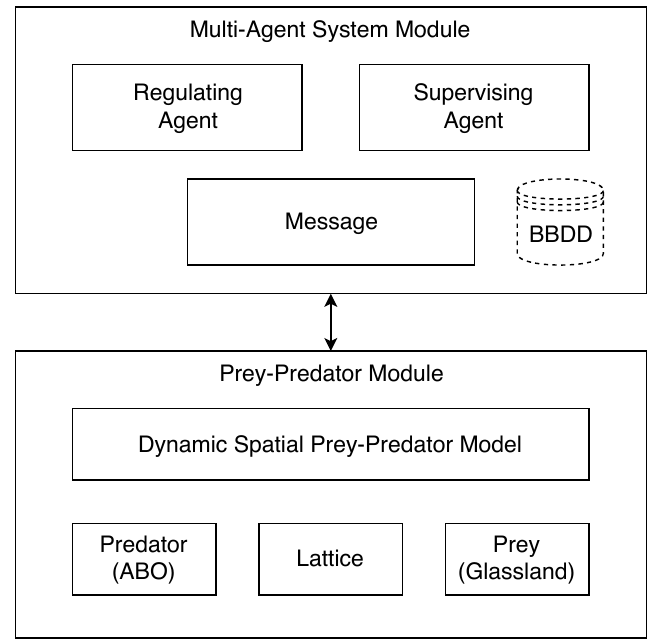
Figure 6. Architecture of dynamic prey–predator spatial model with MAS, CA and